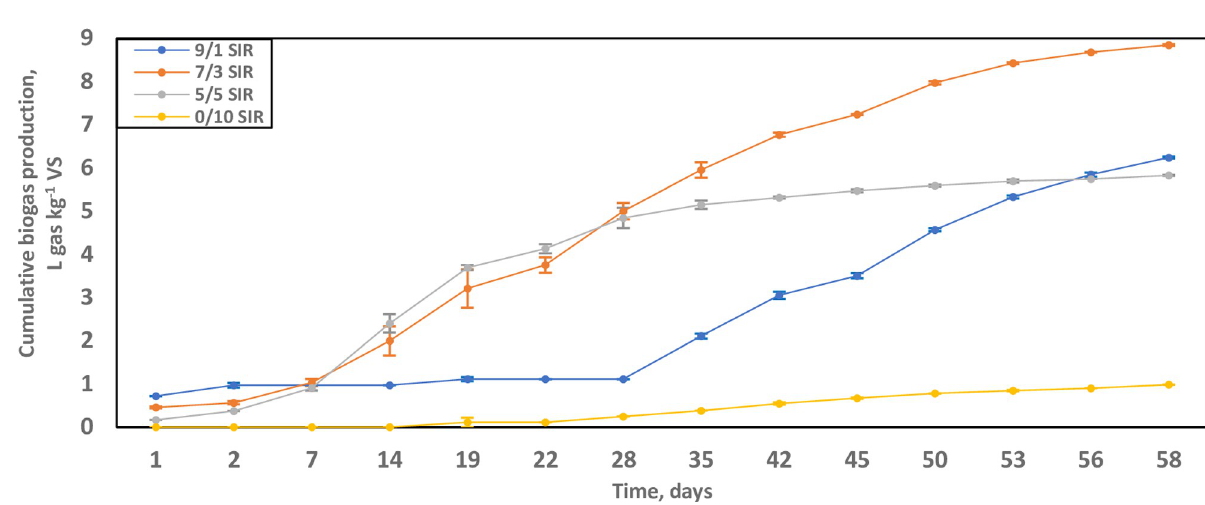
Fig 1. Biogas production curves (L gas kg -1 VS) of digestion setups at 45˚C over 58 days. The substrate-to-inoculum (S/I) ratios were 0/10 [yellow]; 5/5 [grey]; 7/3 [orange]; and 9/1 [blue]. Data are presented as averages with standard error.